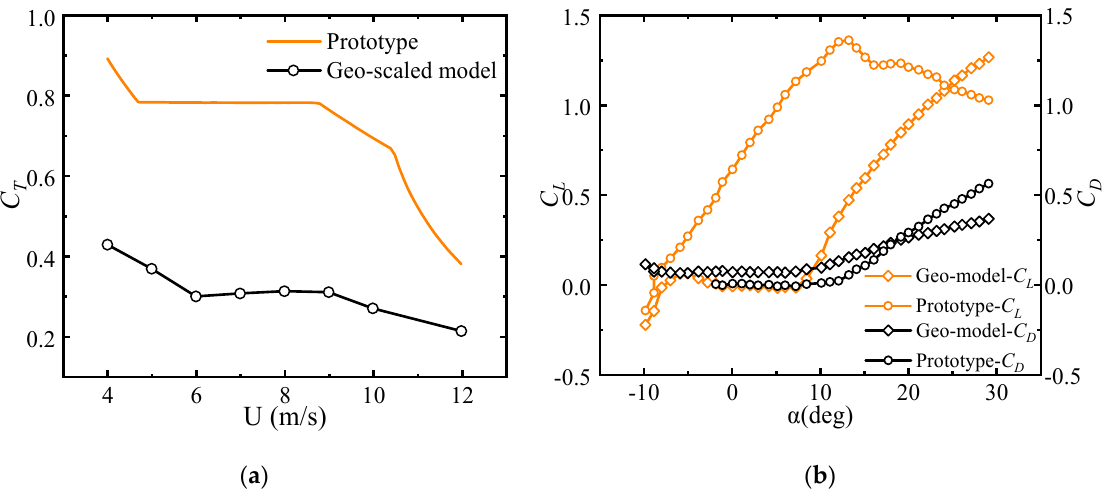
Figure 4. Comparisons of aerodynamic forces of scaled wind turbine models with geometrically scaled blades. ( a ) Thrust coefficient ( C T ) of the scaled wind turbine model; ( b ) lift coefficient ( C L ) and drag coefficient ( C D ) of the blade airfoil.